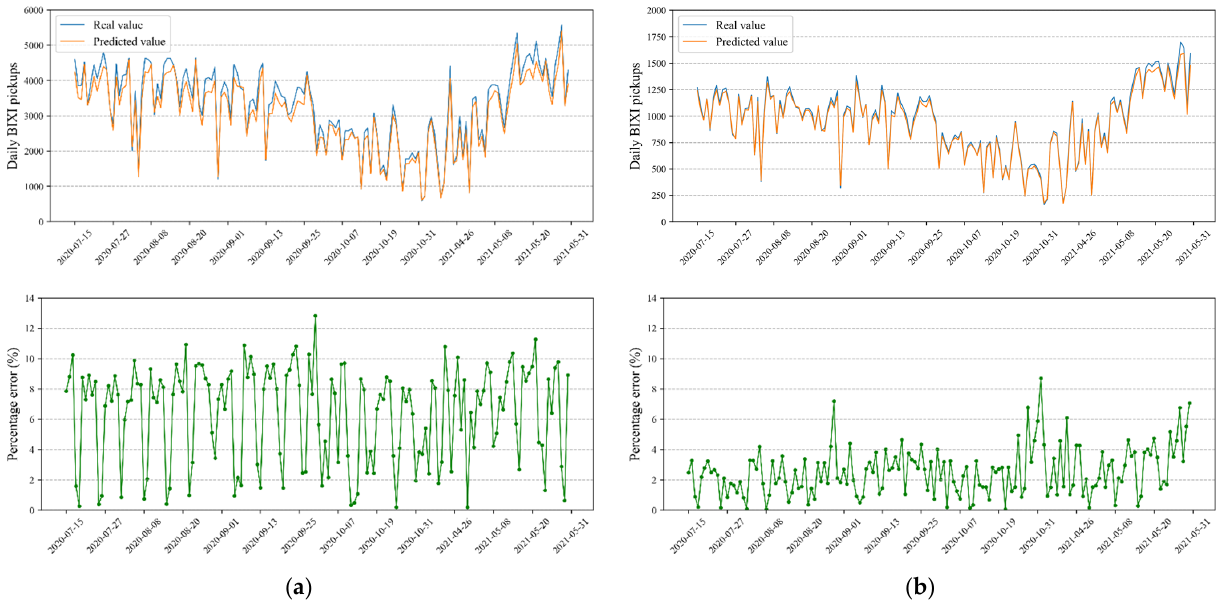
Figure 9. Real and predicted time series as well as the corresponding percentage error of two selected communities on test data. ( a ) Community 3; ( b ) Community 6.